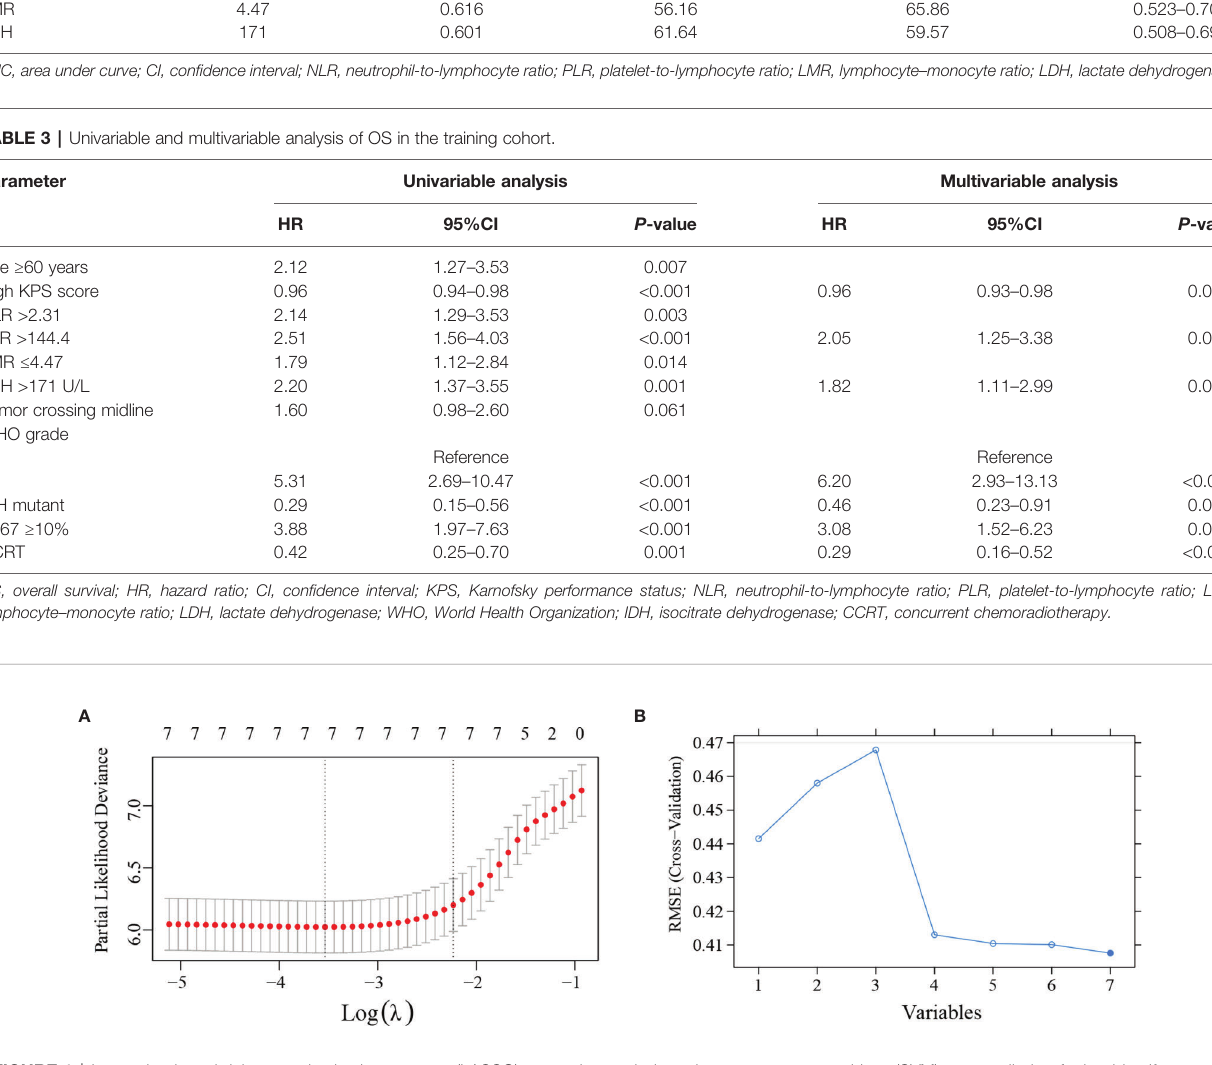
FIGURE 1 | Least absolute shrinkage and selection operator (LASSO) regression analysis and support vector machines (SVM) was applied to further identify prognostic factors in the training cohort. (A) LASSO regression analysis showed that the 7 variables were all left in the LASSO model based on the partial likelihood deviance vs log ( l ). The right dotted vertical line was drawn at the optimal value of l by one standard error of the minimum criteria. (B) SVM showed that the model consists of the top 4 variables almost reached the lowest value of Root Mean Square Error (RMSE) based on 10-fold cross-validation. The blue curve represents the different value of RMSE based on models consists of different variables. Lower values of RMSE represents better consistency between prediction and